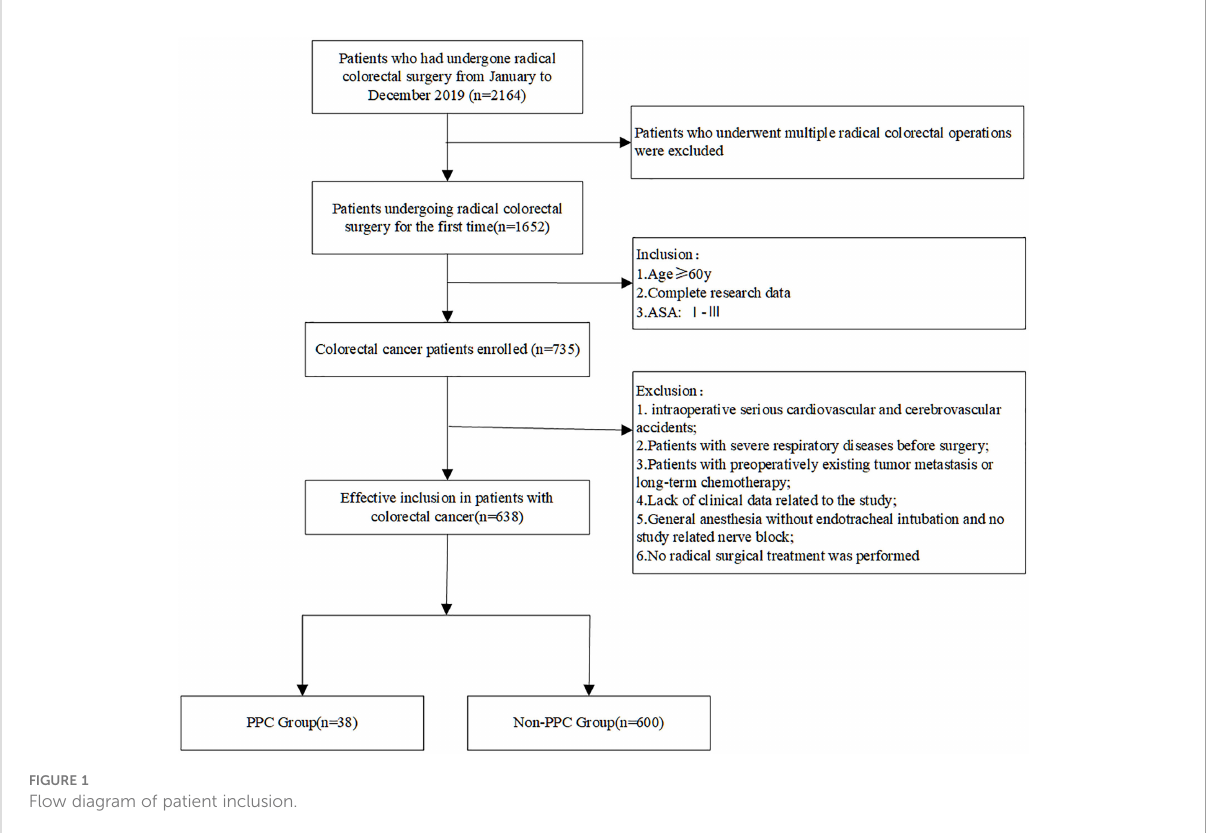
FIGURE 1 Flow diagram of patient